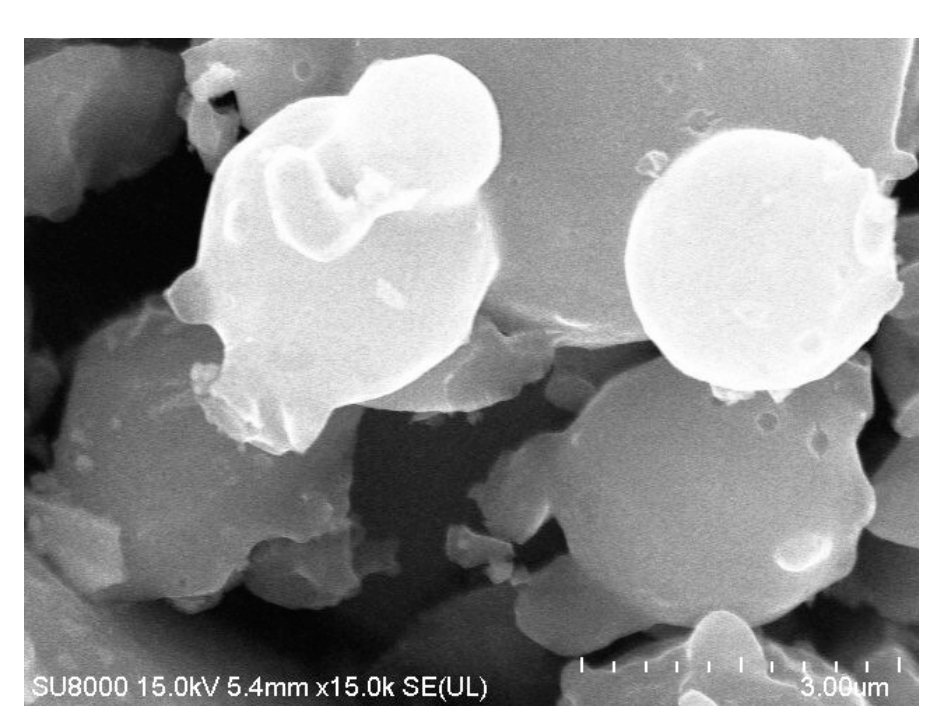
Figure 9. SEM (Scanning Electron Microscope) image of the Ti-SBA-16 catalyst.